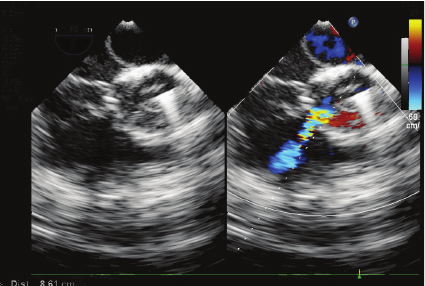
Figure 3: After releasing the closure device, TEE showed no shunt and no effect on the